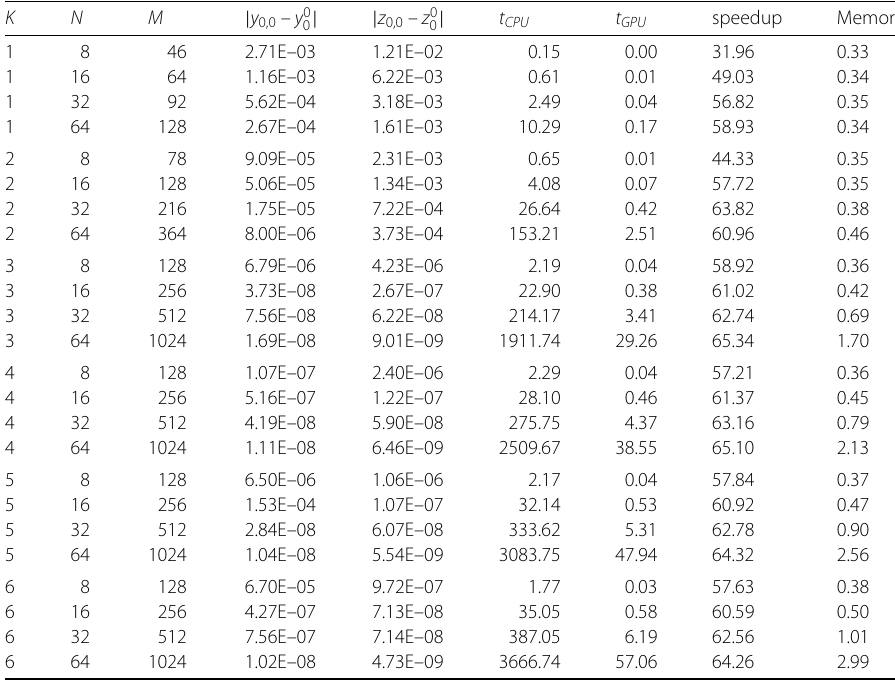
Table 11 The results for Example